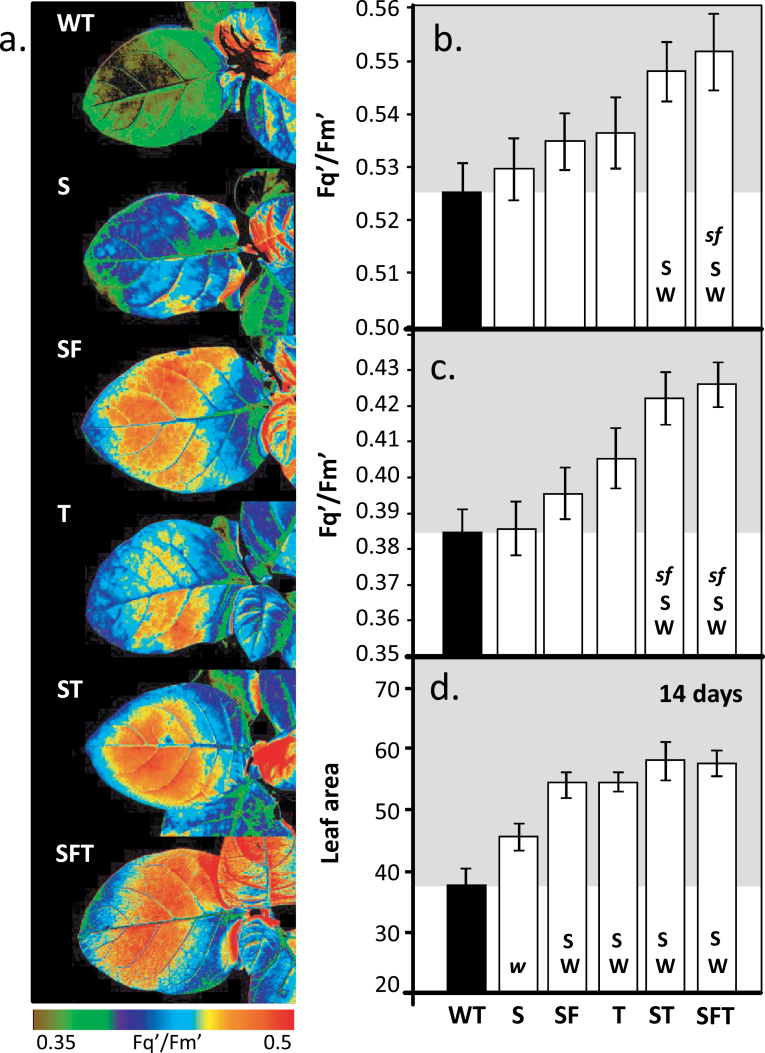
Determination of photosynthetic capacity and leaf area in transgenic seedlings using fluorescence imaging. WT and transgenic plants were grown in controlled environment conditions with a light intensity of 130 μmol m–2 s–1, a 12/12h light/dark cycle for 14 d, and chlorophyll fluorescence was used to determine F
q′/F
m′ (maximum PSII operating efficiency) at two light intensities: (a) 800, (b) 400, and (c) 800 μmol m–2 s–1. (d) Leaf area at time of analysis. Scale bar represents an F
q′/F
m′ of 0.35–0.50. The data were obtained using 12–16 individual plants from 3–4 independent transgenic lines. Significant differences (<0.05) between lines is shown by capital letters [i.e. SFT lines are significantly bigger than wild-type (W) and SBPase over-expressing lines (S)]. Lower case italic lettering indicates lines that are just below significance (>0.05– <0.062). Lines over-expressing SBPase (S), SBPase and FBPA (SF), ictB (T), SBPase and ictB (ST), and SBPase, FBPA, and ictB (SFT) are represented.